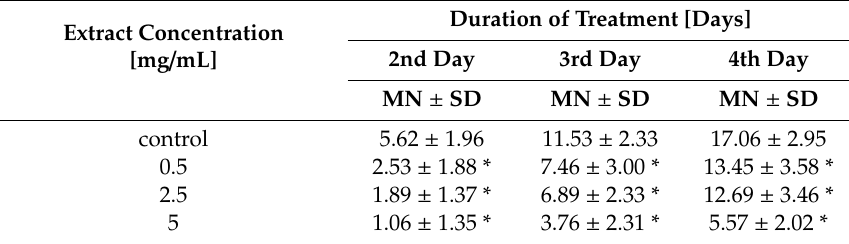
Table 4. The e ff ect of the extract from in vitro shoot cultures of Eryngium alpinum L. [0.5 mg / mL, 2.5 mg / mL, 5 mg / mL] on inhibition of Acanthamoeba trophozoites during four days of treatment.